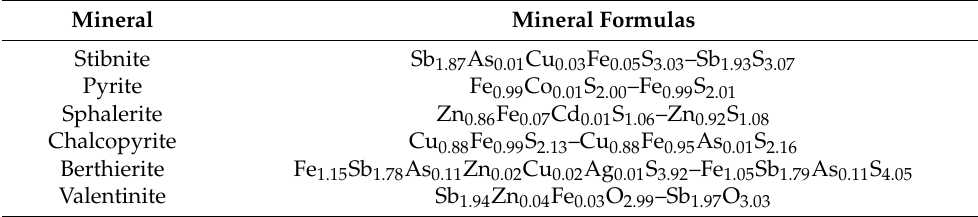
Table 2. SEM–EDS analysis and mineral formulas of stibnite, pyrite, sphalerite and chalcopyrite.